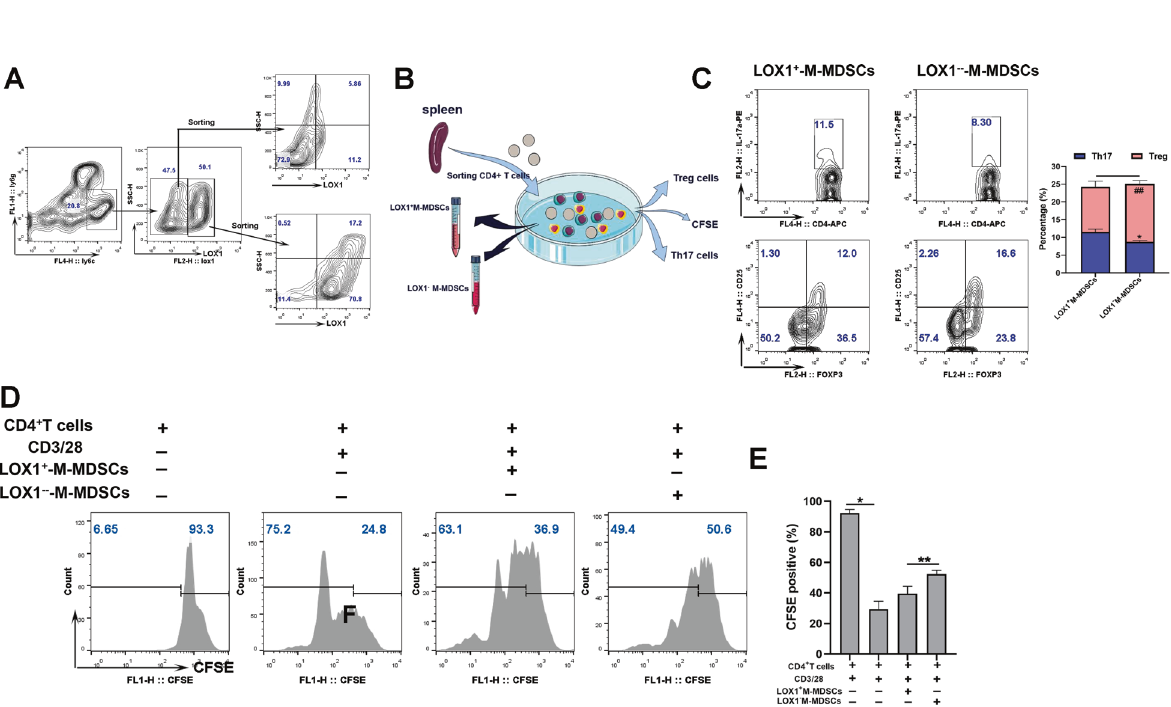
Fig. 7 LOX-1 + M-MDSCs promoted the differentiation of Th17 cells. A Schematic diagram of the sorting of LOX-1 + M-MDSCs and LOX-1 − M-MDSCs in the spleen. B Schematic diagram of co-cultivation of LOX-1 + M-MDSCs and LOX-1 − M-MDSCs with CD4 + T cells. C Flow cytometry analysis of Th17 and Treg cell differentiation. D , E Flow cytometry analysis of the ability of MDSCs to inhibit T-cell proliferation. Data represent the mean scores ± SEM. * P ≤ 0.05, ** P ≤ 0.01, and *** P ≤ 0.001; n = 3 – 5 in each